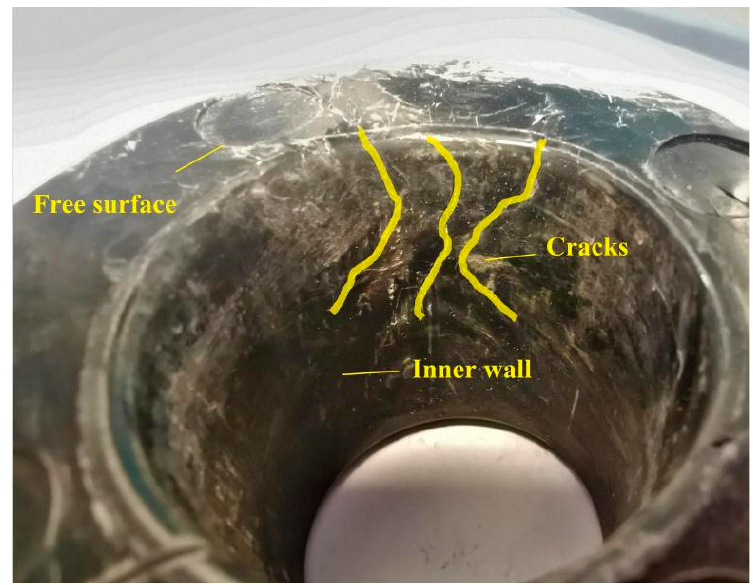
Figure 7. Cracks on the